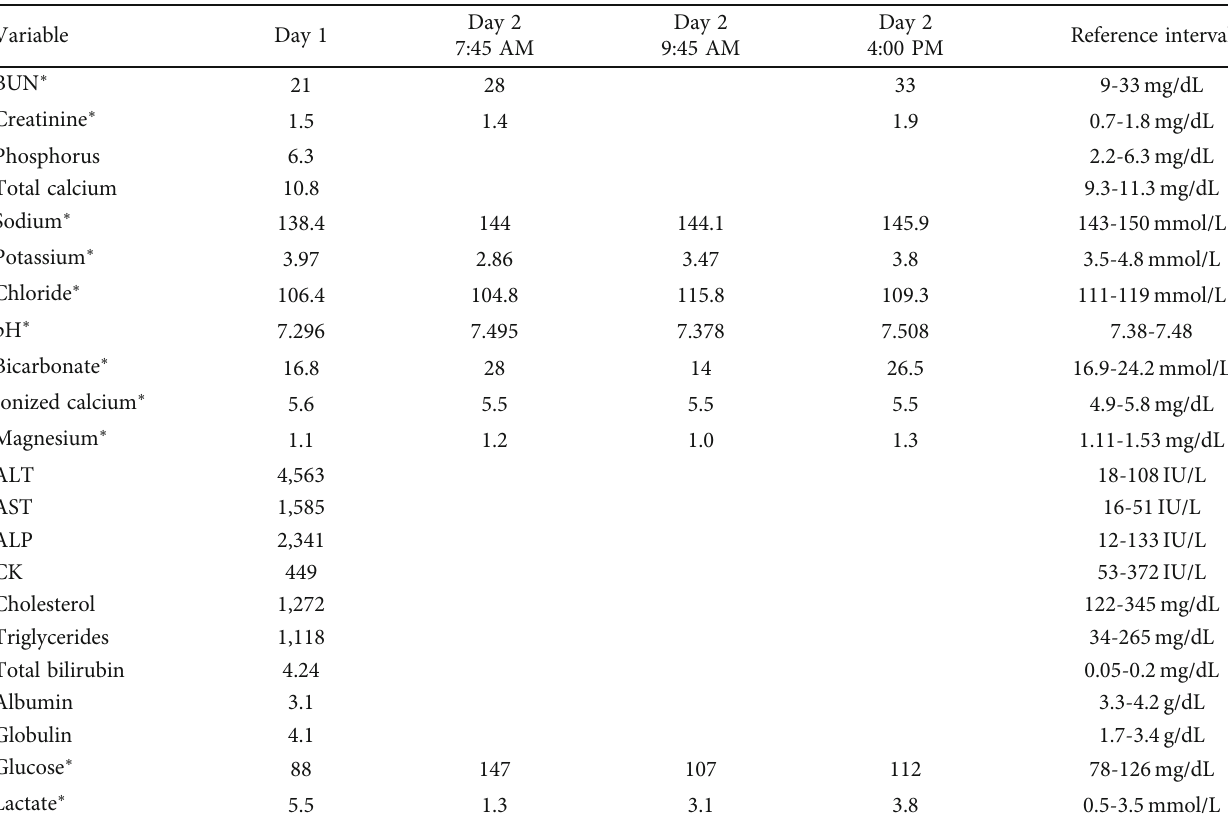
Table 2: Serial biochemistry results. Variables denoted with an asterisk were from blood gas